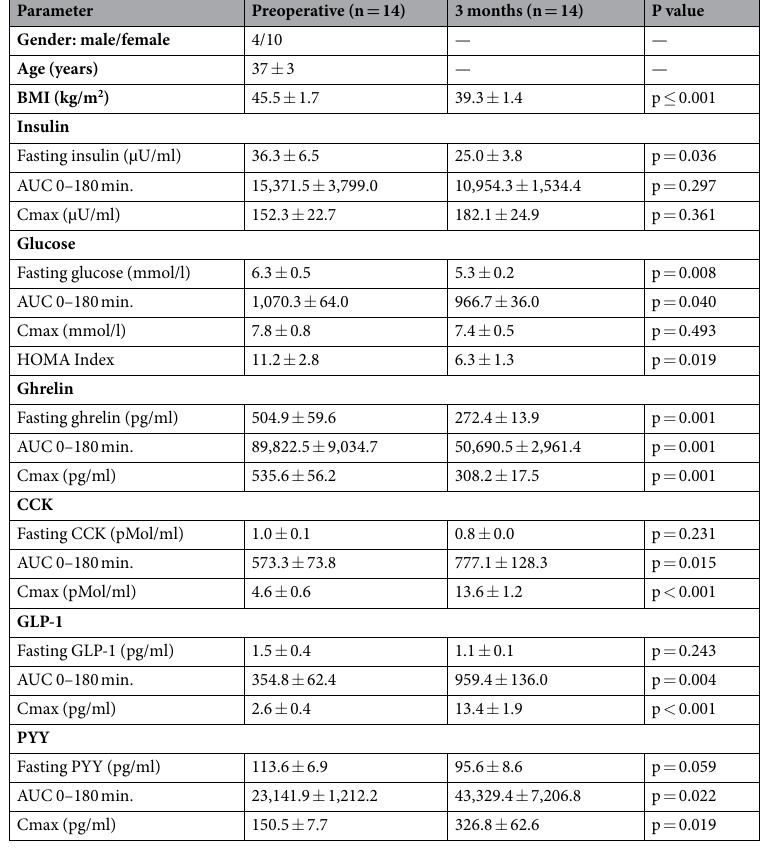
Table 1. Baseline demographics and gastrointestinal hormone levels in morbidly obese patients (Group 1) pre- and 3 months post-LSG after liquid test meal (408 kcal) stimulation. Data represent means ± SEM; AUC = area under the concentration time profile; Cmax = maximum plasma concentrations. p-value: pre versus post- surgery, using a Student’s paired